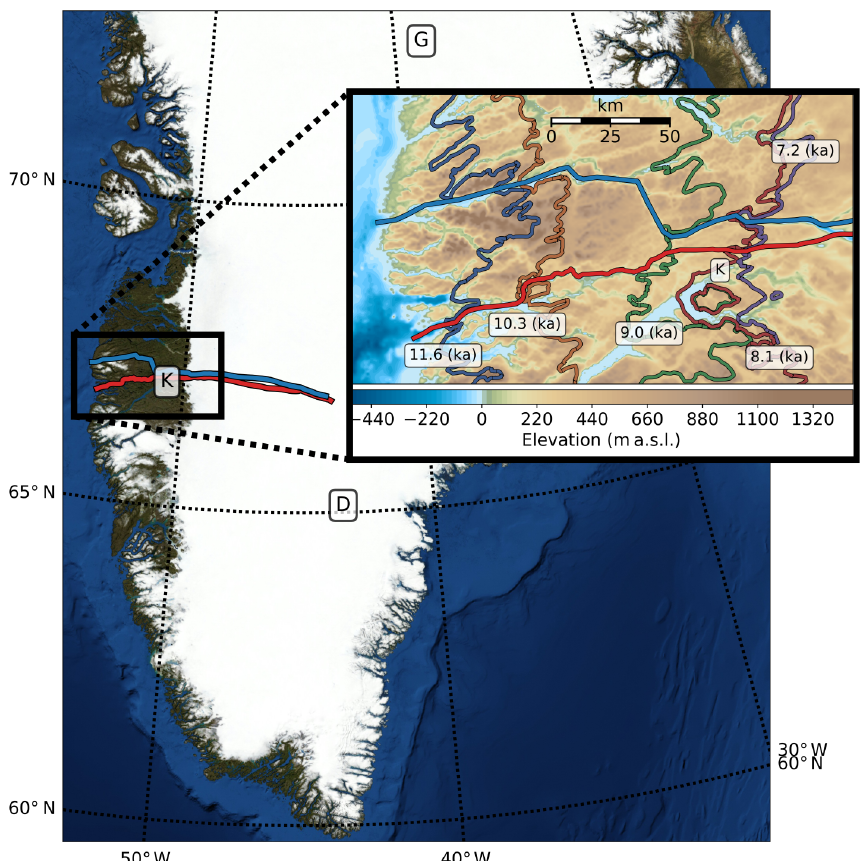
Figure 1. K marks the position of Kangerlussuaq, while D and G mark the locations of the Dye-3 and GISP2 boreholes, respectively. Northern and southern paleo-flow lines are shown as blue and red lines running left to right. The inset shows a detailed view of the modeled region. Modern bedrock elevation is expressed in meters above sea level. Historical moraines dating from 11.6 to 7.2ka are indicated by labeled